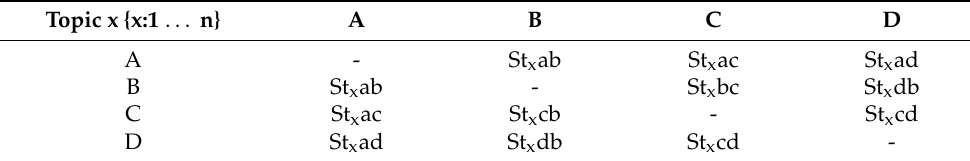
Table 2. Confidence Criterion Matrix for Subject X